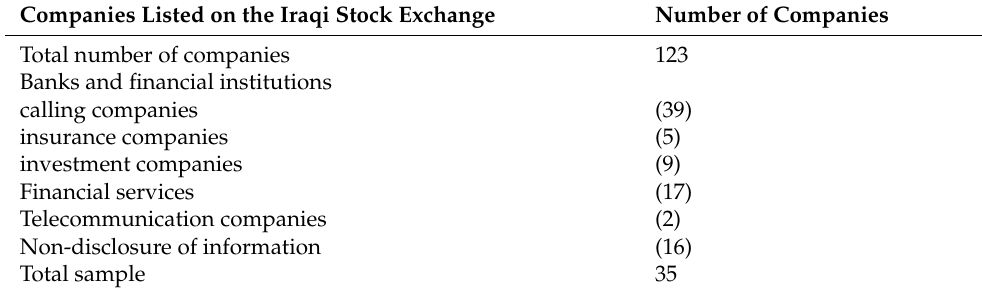
Table 1. The number of